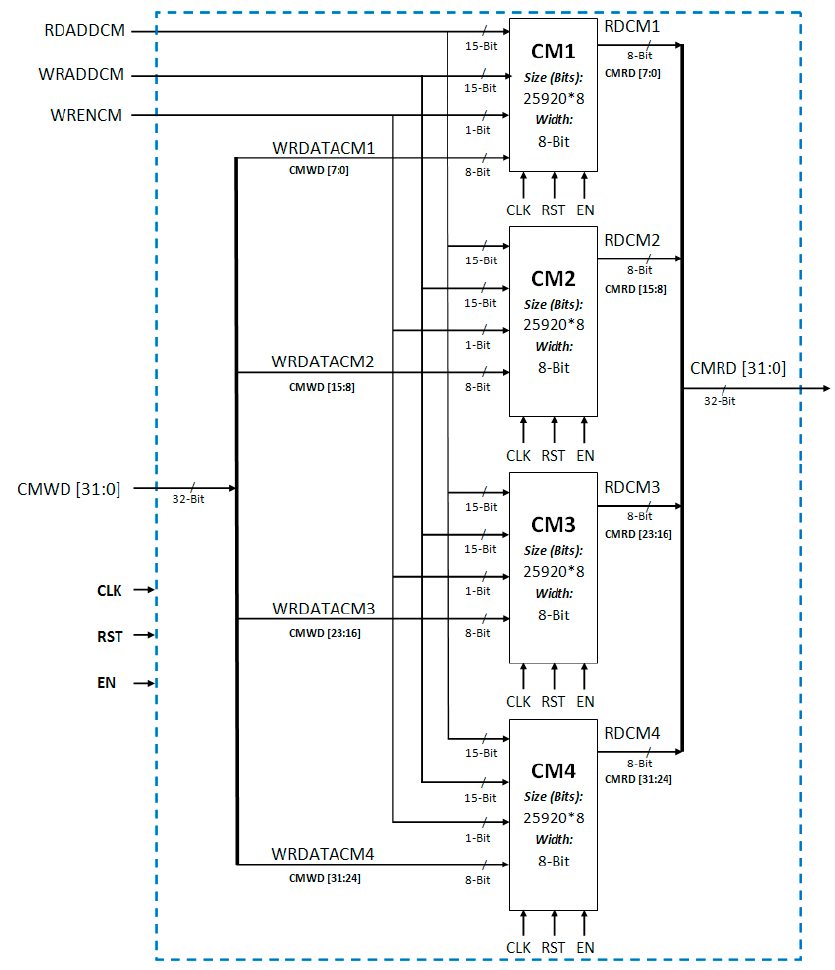
Figure 11. Centroid memory architecture.